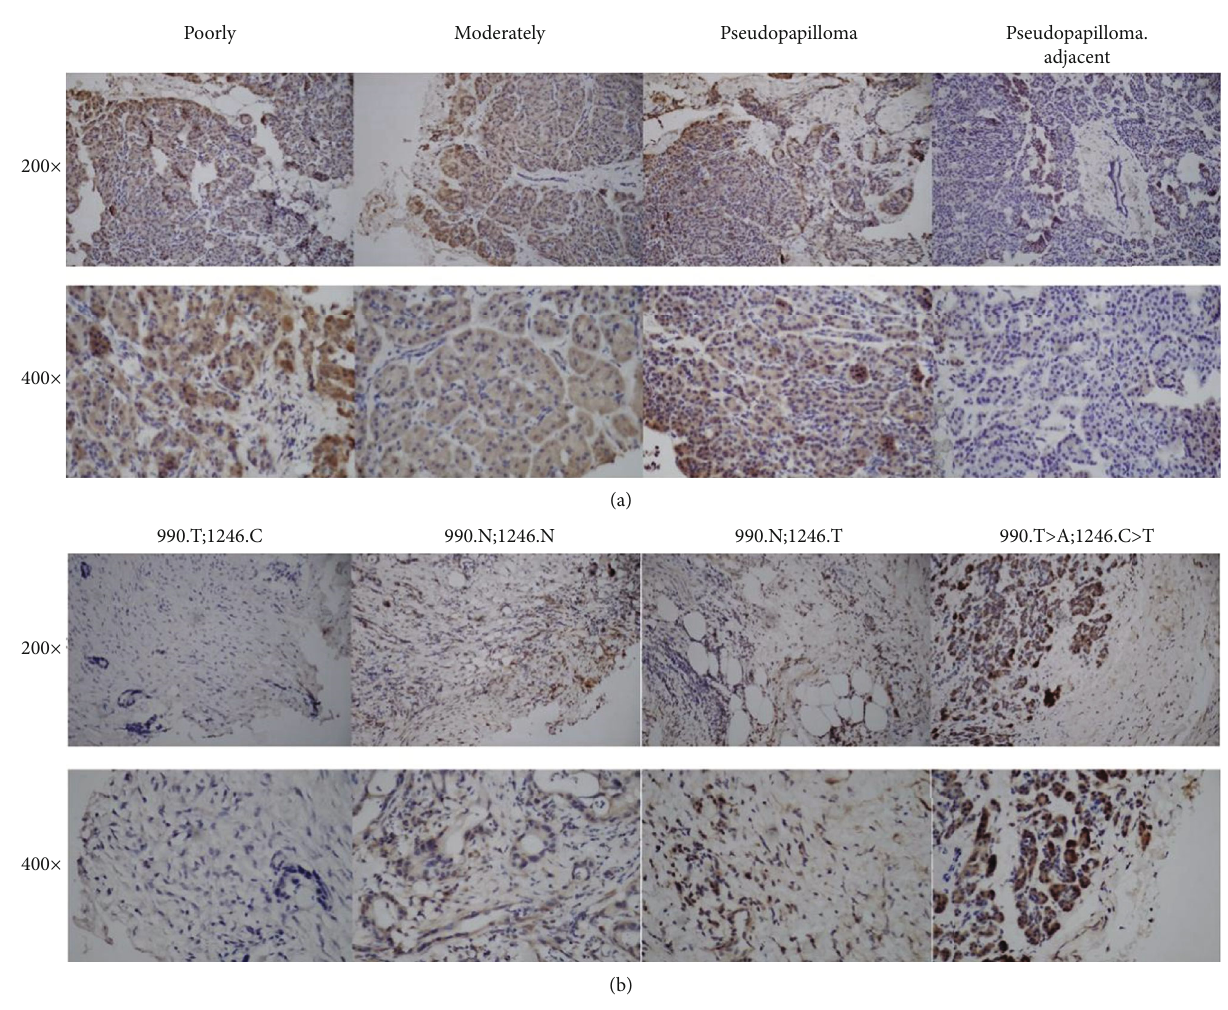
Figure 2: The level of DDIT4 and gene mutation/pathological grading. (a) Immunohistochemistry revealed upregulation of DDIT4 in poorly di ff erentiated adenocarcinoma tissue, moderately di ff erentiated adenocarcinoma tissue, and solid pseudopapilloma tissue compared with adjacent normal tissues. (b) The level of DDIT4 increased in DDIT4 3 ′ -UTR gene mutation (990.T > A;1246.C > T) compared with pancreatic cancer tissues without gene mutation. The expression level of DDIT4 increased both in the cytoplasm and